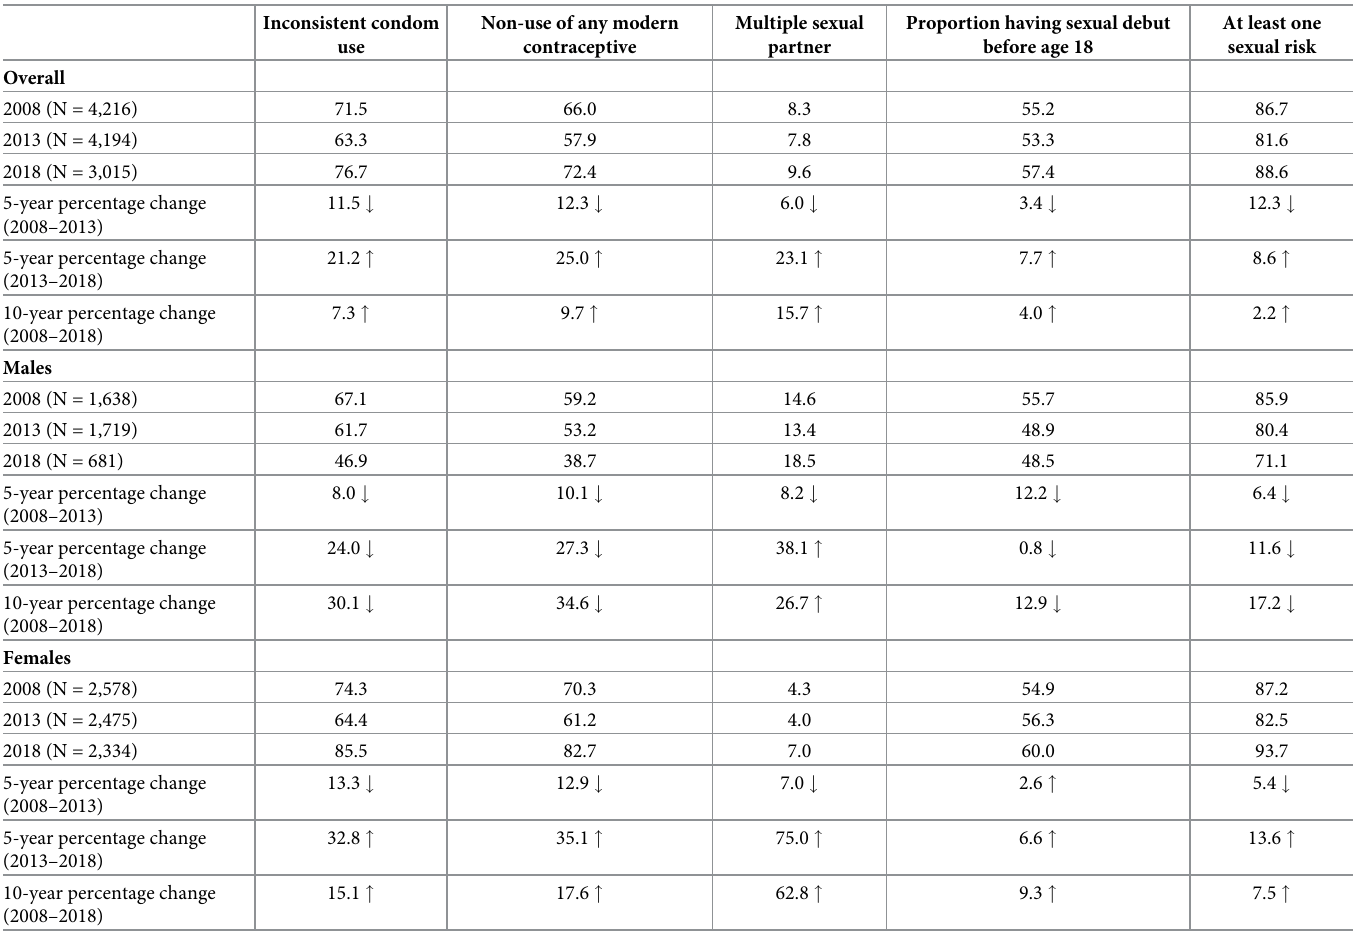
Table 3. Changes in contraceptive and sexual behaviour of unmarried young people in